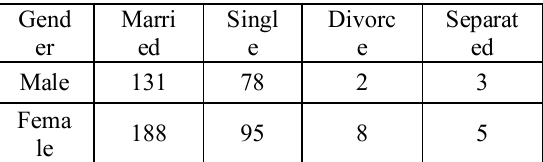
Table: 2 Distribution of Patient according to Marital Status